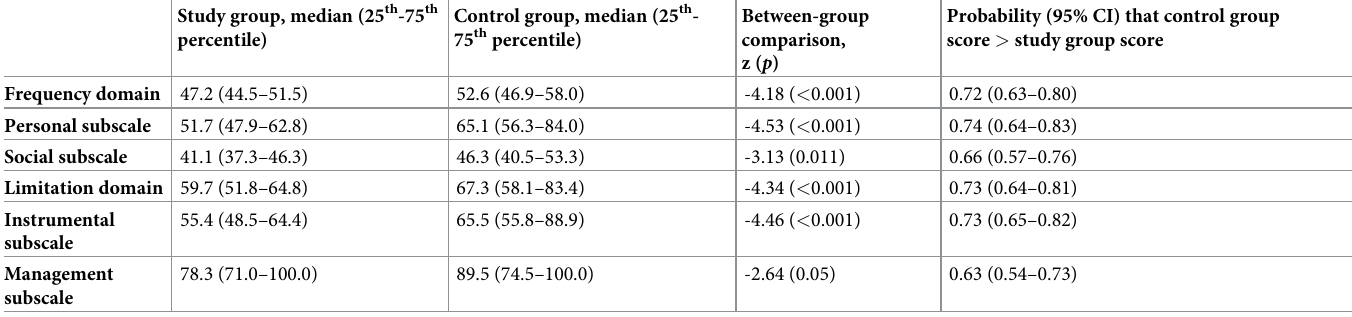
Table 2. Between-group comparison of LLDI scores.